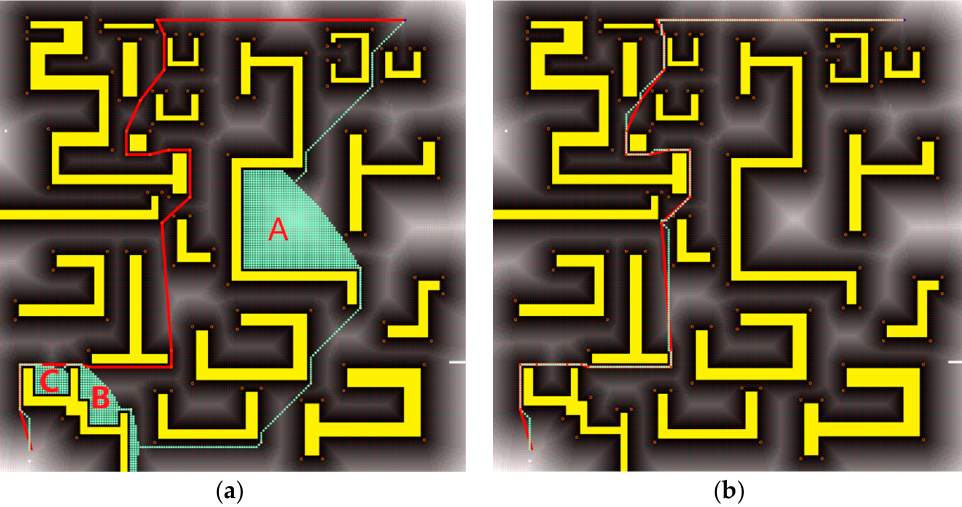
Figure 12. Performance comparison between agent X and Y . ( a ) The resulting path of agent X who simply uses LRTA* to engage a global search in a DM. As the light green trajectory shows, repeated heuristic corrections and meaningless movements caused by local minima (such as the regions denoted by identifiers A, B, and C) seriously reduce the rationality of the resulting trajectory when it is compared with the high level path searched by A* form the DM-based subgoal graph (denoted as the red trajectory); ( b ) The resulting path of agent Y who adopts LRTA* to refine the high-level path searched from the DM-based subgoal graph. Due to the sparse and h-direct reachable feature, Agent Y prefers to expand cells between consecutive subgoals and thus can e ffi ciently avoid local minima. Therefore, the resulting path (shown as light green trajectory in ( b )) is, to a large extent, close to the optimal path denoted as the red trajectory.